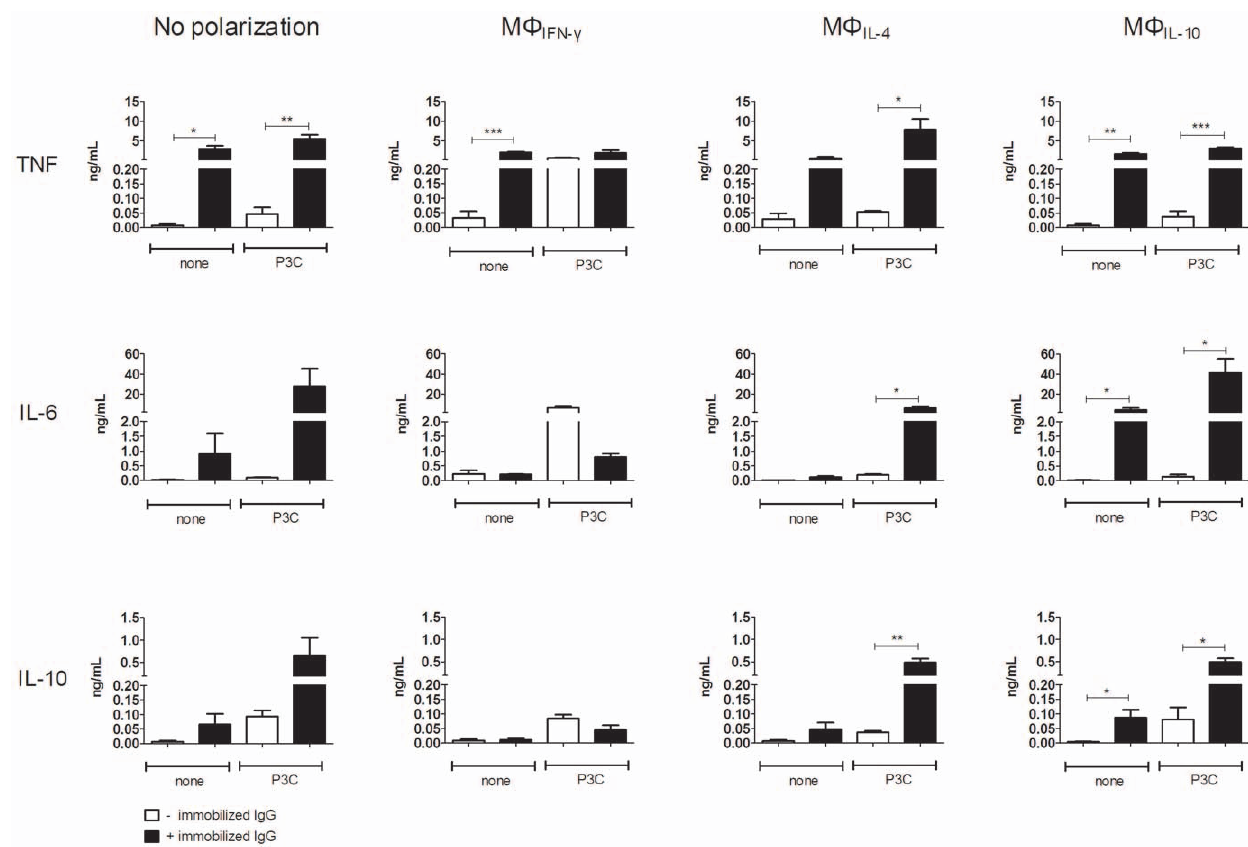
Figure 7. TNF, IL-6, and IL-10 production by M W IFN- c , M W IL-4 , and M W IL-10 after stimulation with immobilized IgG and P3C. Healthy peripheral blood monocytes were cultured for 4 days in medium or in medium supplemented with IFN- c , IL-4, or IL-10. Polarized macrophages were not stimulated, or stimulated for 20 hours with P3C, in the presence or absence of immobilized IgG. Bars represent the mean 6 SEM of 3 independent experiments. *p , 0.05, **p , 0.01, ***p , 0.001.